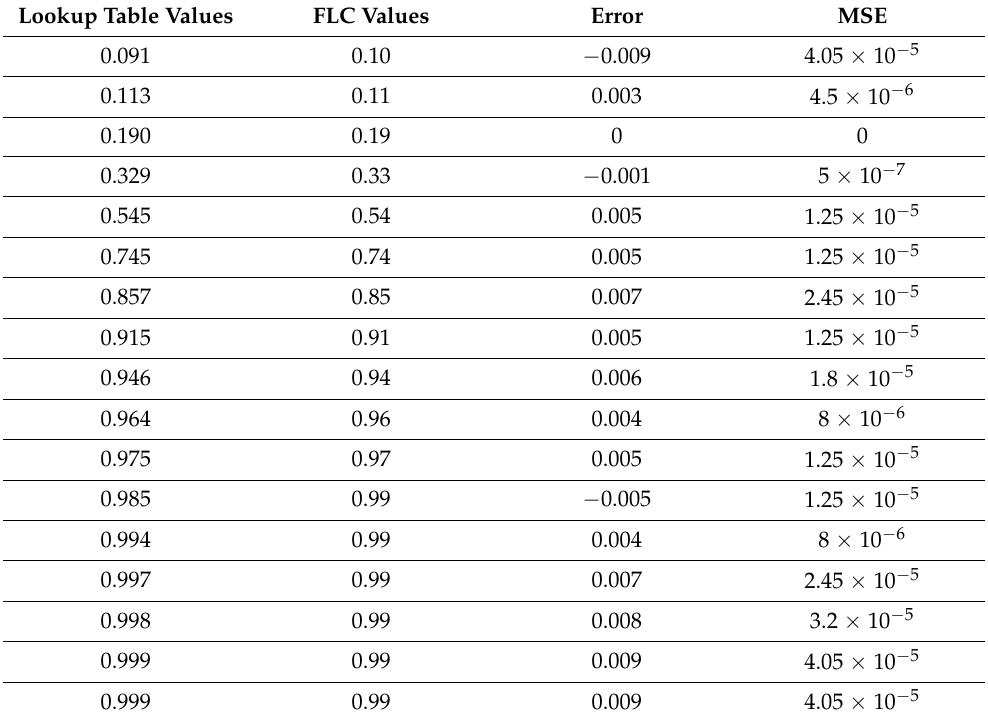
Table 2. MAP estimation using FLC-based observer